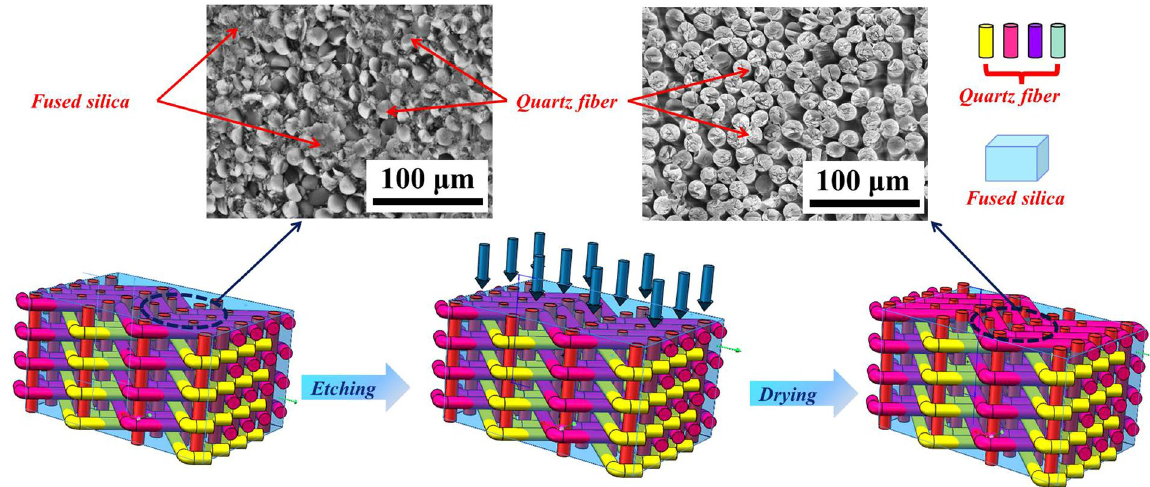
Figure 1. Schematic of etching treatment on SiO 2f /SiO 2